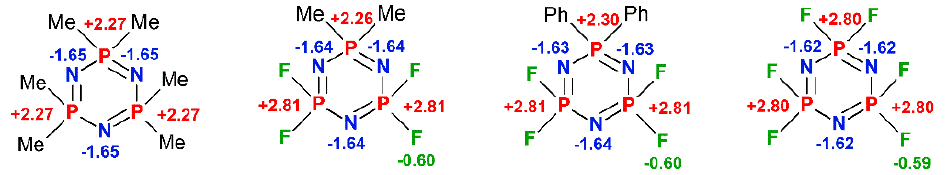
Figure 7. Examples of NBO charges on P and N atoms depending on the nature of substituents on the P atoms in cyclophosphazenes. [56] Of note is the independence of the charge on N from the substituent on P.